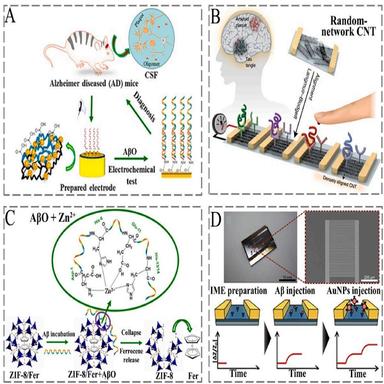
(A) AuNPs− PEDOT− PTAA/PrPC sensor for the detection of Aβ42 oligomers in AD mice tissue from ref.)]. Copyright 2019 American Chemical Society. (B) A densely aligned CNT sensor array for AD biomarkers in blood from ref.. Copyright 2020 Nature Communication. (C) ZIF-8 for optical and electrochemical sensing of Aβ42 oligomers from ref.)]. Copyright 2019 American Chemical Society. (D) An impedance biosensor for the blood-based Aβ42 detection using AuNPs sandwich assay fr